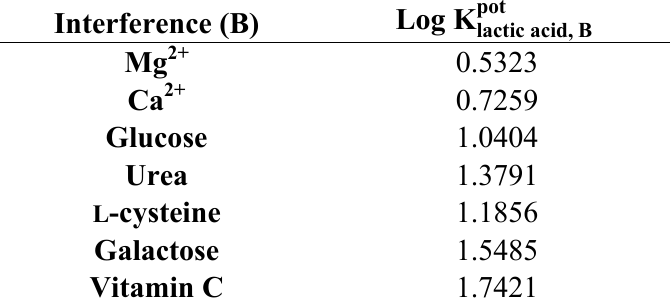
Table 1. Selectivity coefficient in 10 − 3 mM.